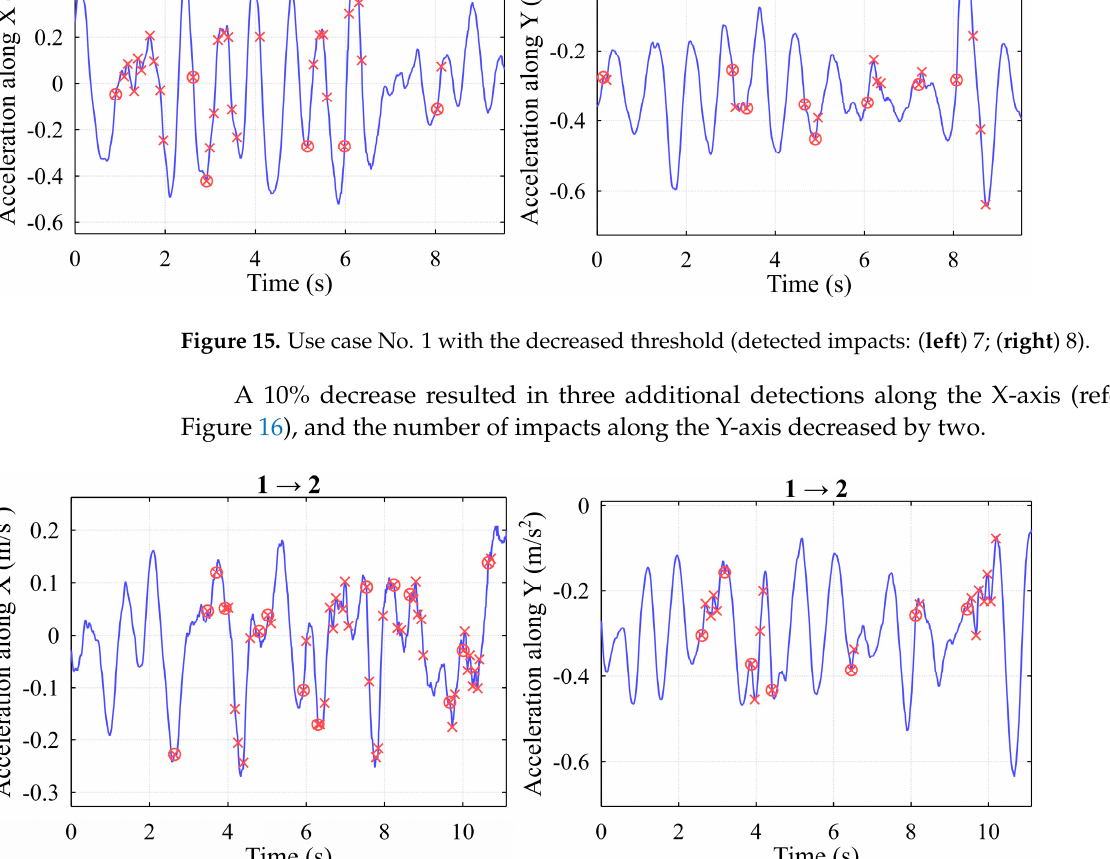
Figure 17. Use case No. 3 with the decreased threshold (detected impacts: ( left ) 10; ( right ) 2). Further changes to the level of the threshold ( ±20% ), with smaller steps ( ±2% ), gave interesting results (see Table 1). From the provided results it is visible that the dependency is not linear for both the X and Y axes. In some cases, the increase in the threshold in- creased the number of detections up to several times (3rd case of the Y-axis), reaching eleven detected impacts from nominal two at the base parameters of the IDM. On the other hand, the second case showed quite different results. The number of detected im- pacts decreased by one from the nominal threshold level, jumping up and down at each step. Similar situations occurred with the X-axes of all three use cases. This is a clear indi- cation that each use case study is unique and requires a full estimation of the dynamics of the machinery, the impact on the environment, and the randomized influence from the surrounding technological processes. Table 1. Detection of impacts with varying levels of the threshold. Use case No.